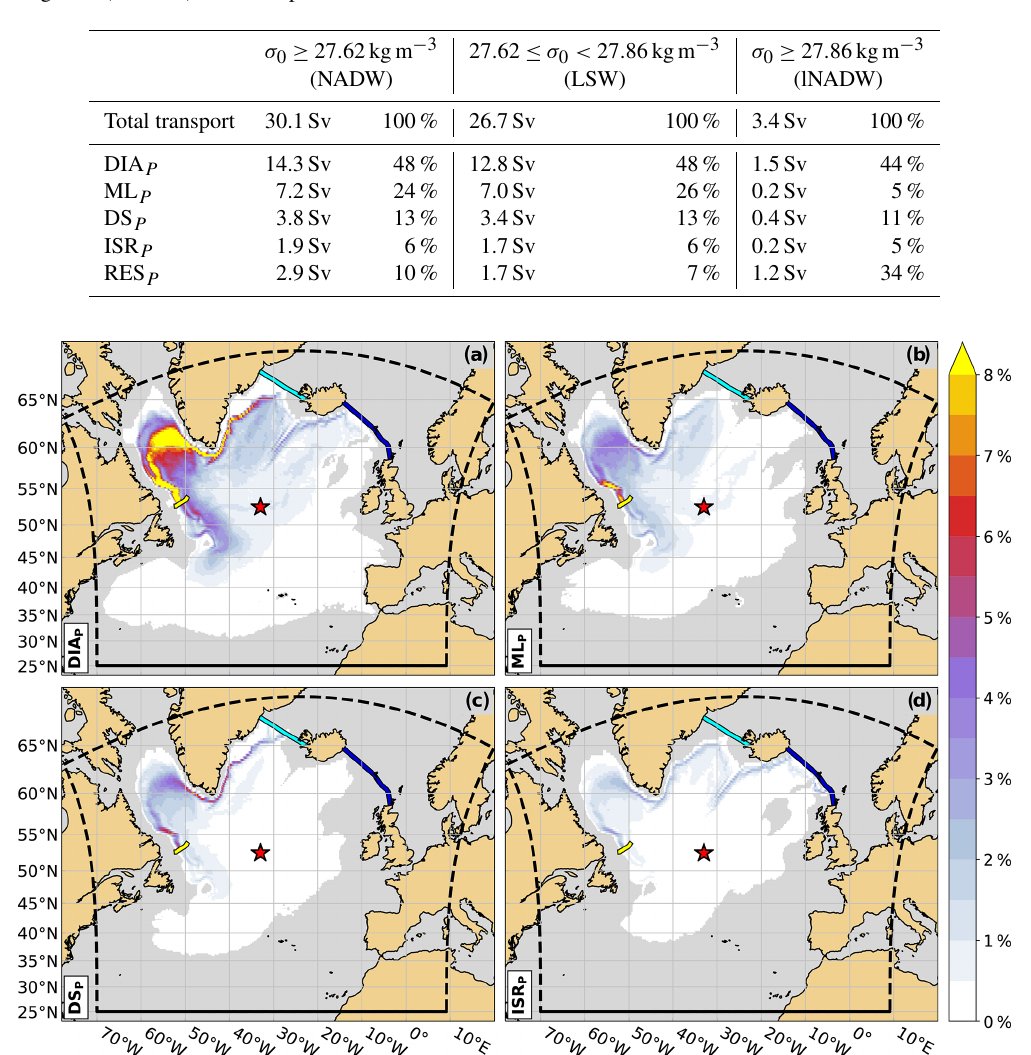
Table 1. Mean transport from 2010–2019 (in Sv) at 53 ◦ N associated with each particle category (DIA P , ML P , DS P , ISR P , and RES P ), as detailed in Sect. 2.1.3, as well as their relative contributions (in %) for σ 0 ≥ 27 . 62kgm − 3 (NADW), 27 . 62 ≤ σ 0 < 27 . 86kgm − 3 (LSW), and σ 0 ≥ 27 . 86kgm − 3 (lNADW). The transports are rounded to 0.1Sv.